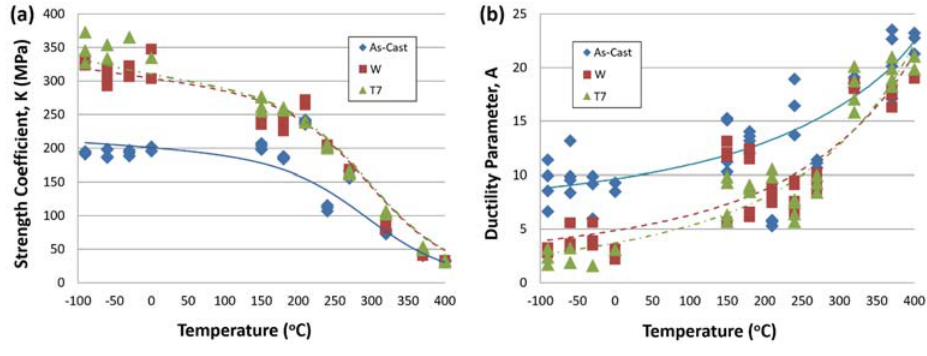
ε n K  ) with the experimental data. Figure 6a,b t t ) with the experimental data. Figure